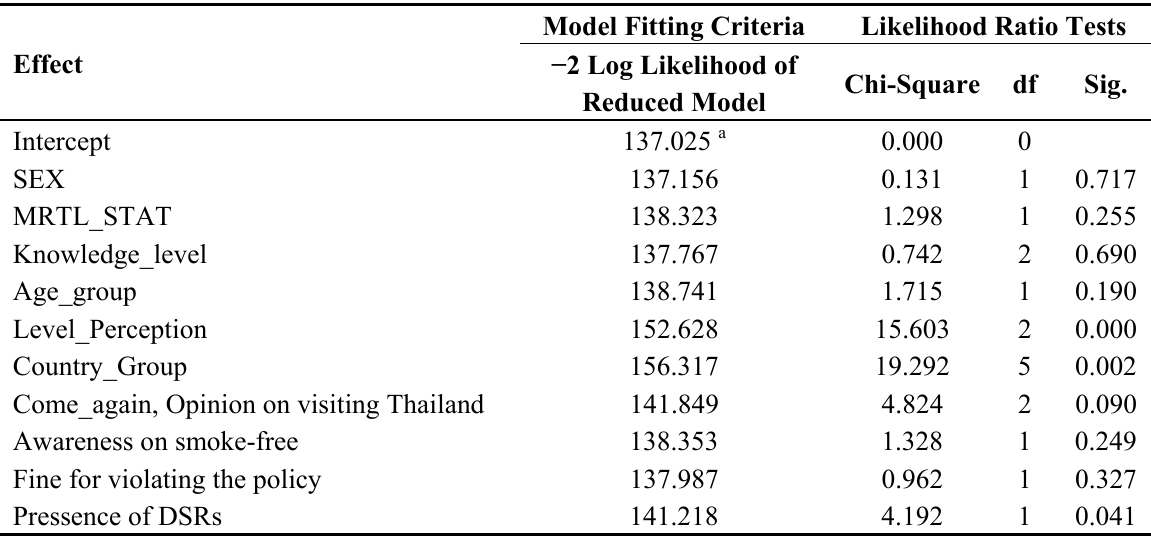
Table 5. Likelihood Ratio